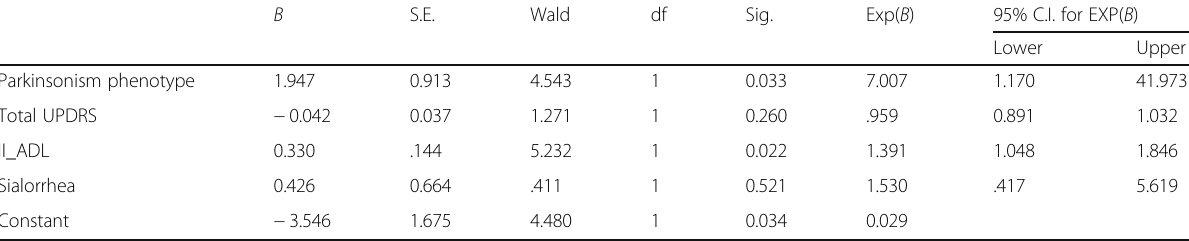
Table 3 Predictors of dysphagia in